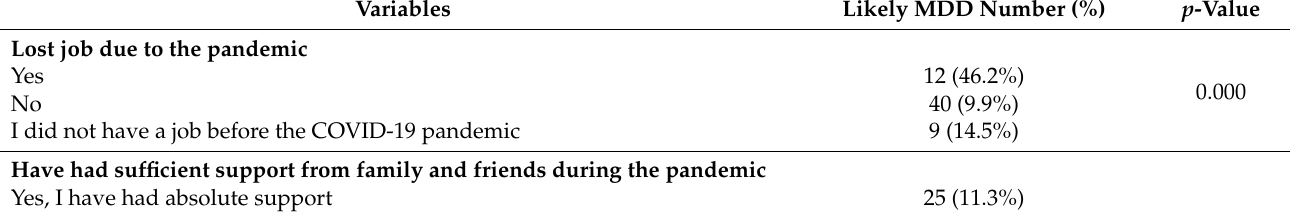
Table 4. Chi-squared and Fisher’s exact test, * test of association between social and clinical antecedents and likely MDD. Variables Likely MDD Number (%) p